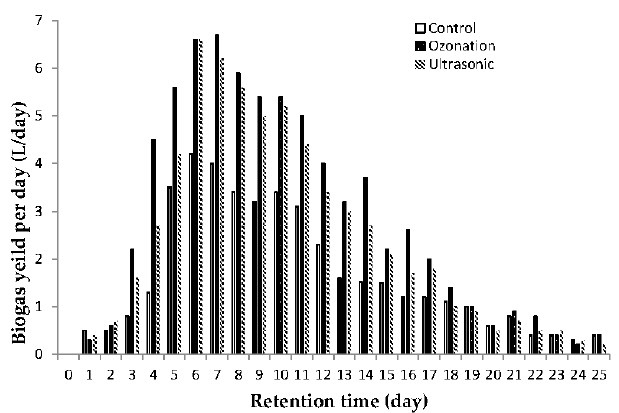
Figure 4. The daily biogas productions from anaerobic digestion of digested sludges pretreated by ultrasound and ozonation.